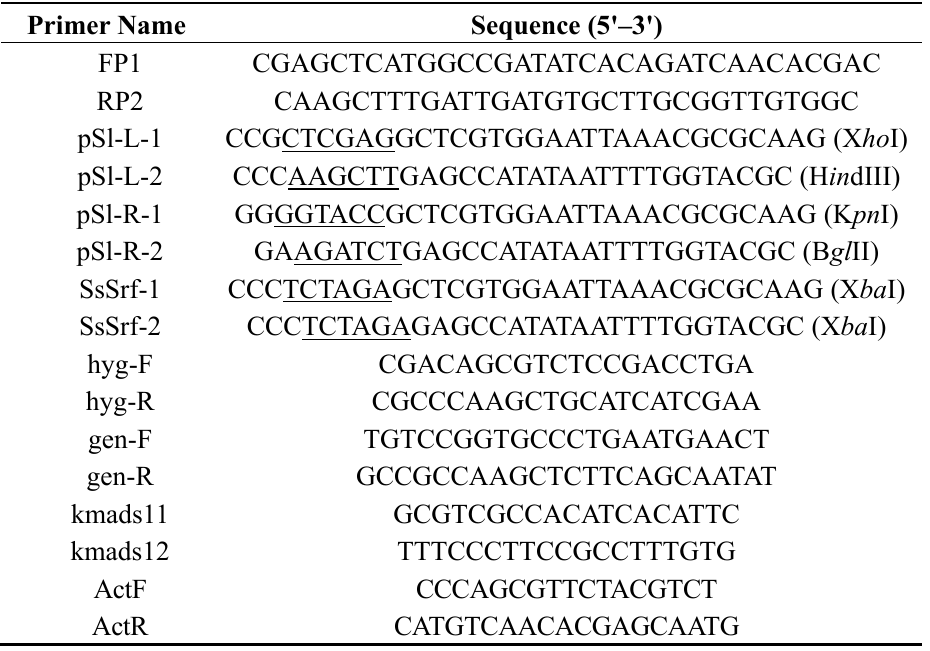
Table 1. Primers used in this